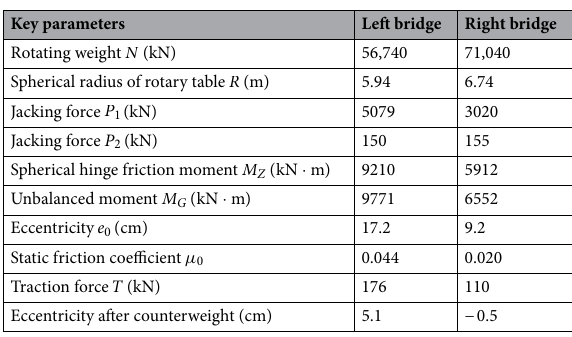
Table 3. Statistical table of key parameters’ calculation